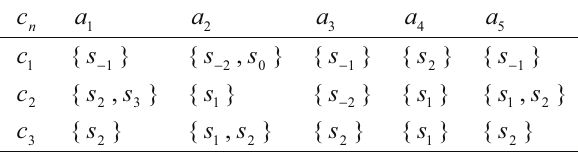
Table 3. Decision matrix provided by